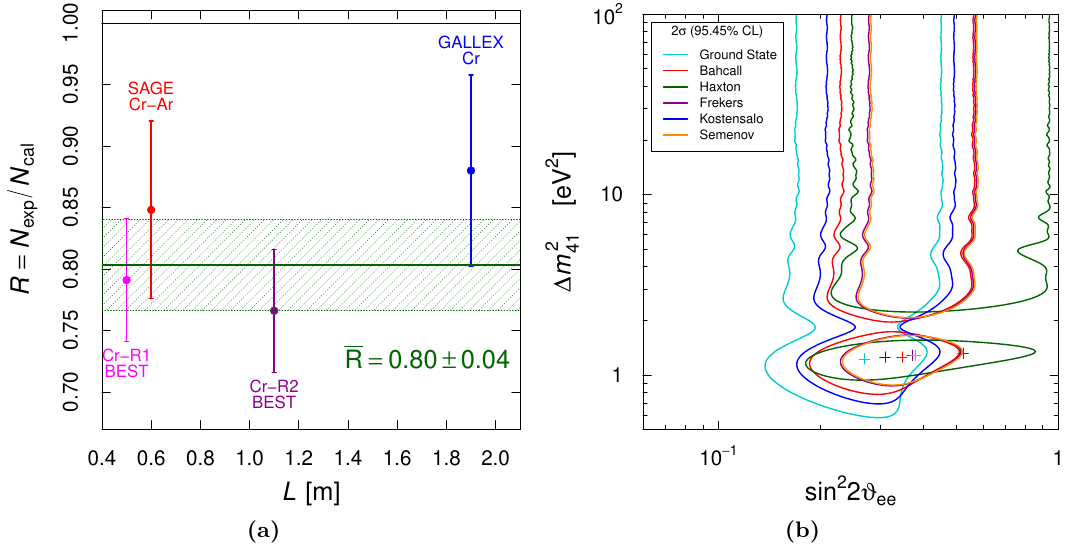
Figure 1. (a) Ratios of observed and predicted event rates in the Gallium source experiments obtained using the Bahcall cross sections [16]. (b) Contours enclosing the 2 σ allowed regions in the ( sin 2 2 ϑ ee , ∆ m 2 ) plane obtained from the Gallium data with the different cross sections in table 1. 41 The best-fit points are indicated by crosses. Note that the Frekers (magenta) and Semenov (orange) contours are almost